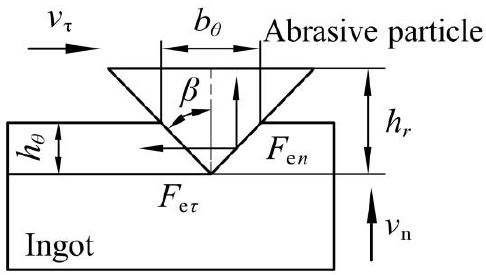
Figure 2. Deformation of the wire saw.